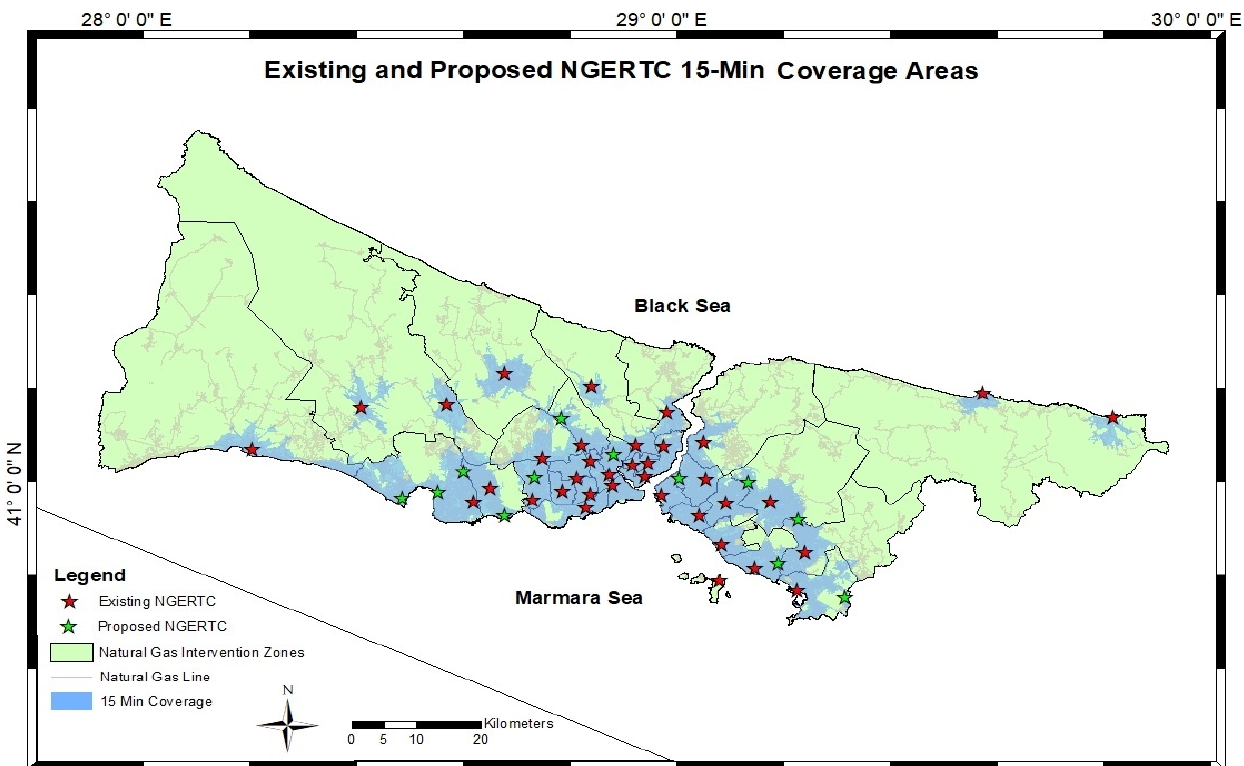
Figure 15. Existing and proposed NGERTC 15 min coverage areas. Table 8. Coverage percentage and number of existing and proposed NGERTCs by intervention